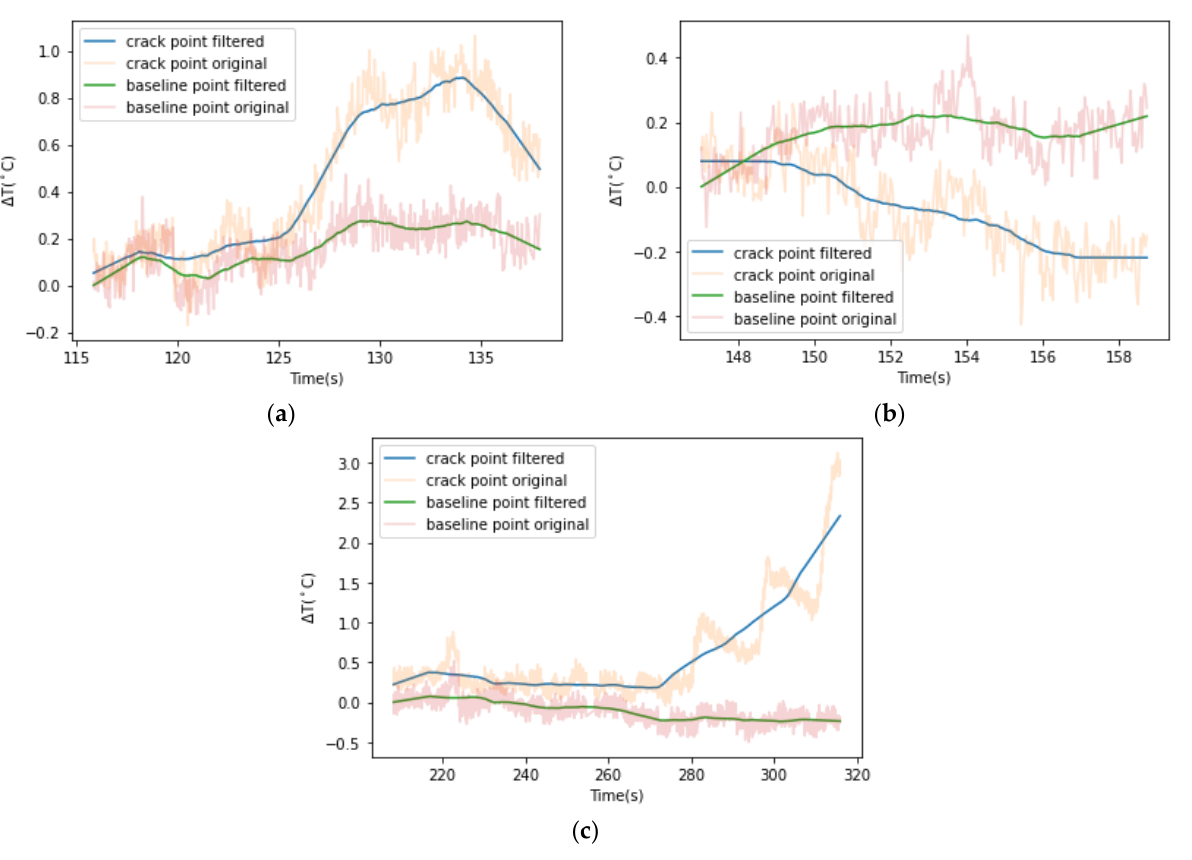
Figure 13. Temporal temperature variation at crack I1 D2 I5 and their immediate baseline A, B, C: